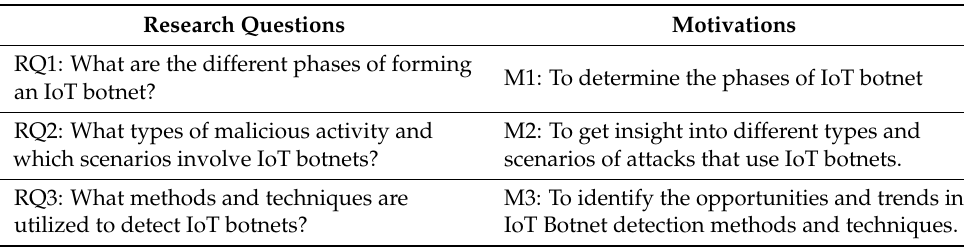
Table 3. Research questions and the motivations of the